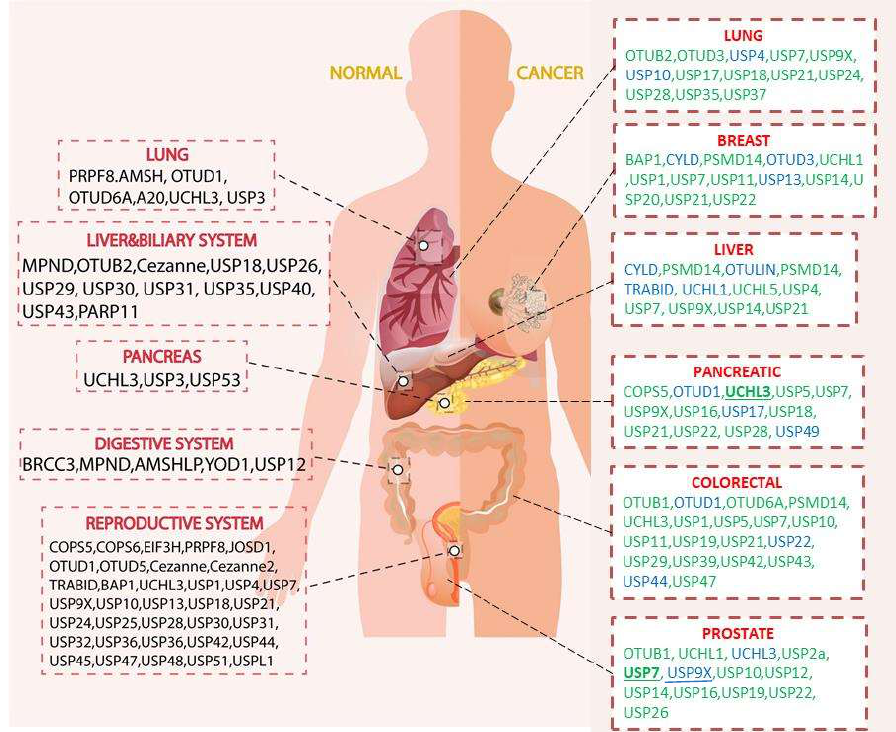
Figure 1. Deubiquitinases (DUBs) in different organs. The figure is divided into two panels, the normal condition (left), and the cancer (right). The normal condition is based on the [7], and the inclusion criteria are limited to the DUBs that are significantly overexpressed, relative to their mean expression in other tissues. Five systems/organs are selected, which are the lung, liver and biliary system, pancreas, digestive system, and reproductive system. While the cancer (lung, breast, liver,